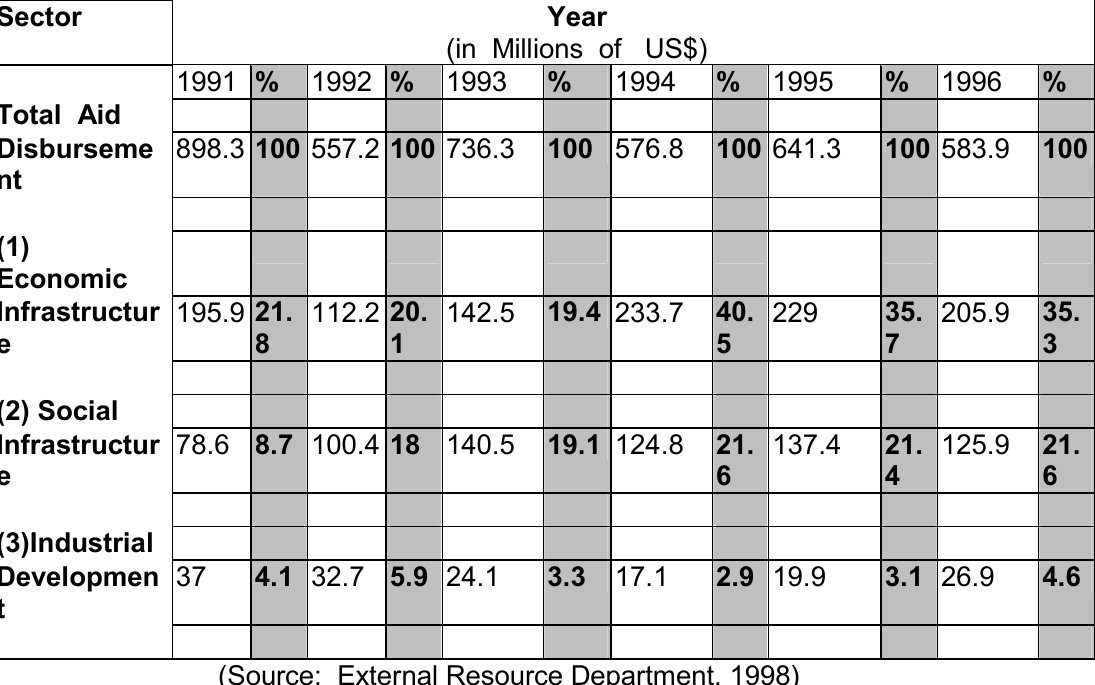
Table 4. Foreign aid disbursement from 1991 to